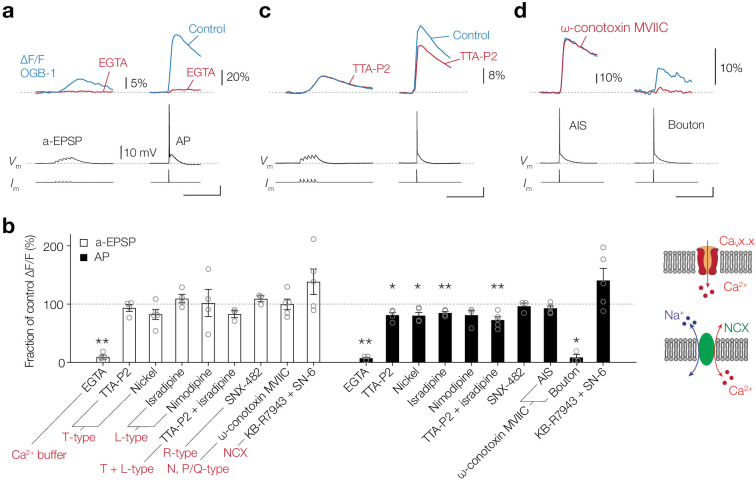
CaV channels play a partial role in activity-dependent Ca2+ entry at the AIS.(a) Top, example traces of ∆F/F (100 μM OGB-1) in the AIS evoked by an a-EPSP (left) and AP (right), before (blue) and after (red) bath application of EGTA (2.5 mM). Bottom, somatic Vm and current-clamp protocols. Scale bars bottom right, 20 mV, 100 ms. (b) Left, population data for the effect of an extracellular Ca2+ buffer, CaV channel blockers and NCX on the peak ∆[Ca2+]i signal in the AIS in response to an a-EPSP (open bars) and AP stimulation (closed bars). Data are shown as ratio to the pre-drug peak Ca2+ responses measured in the same neuron. One-tailed ratio paired t-tests, *p<0.05 and **p<0.01. Open circles represent individual cells and the bars show the mean ± s.e.m. Right, schematics of Ca2+ entry in the axoplasm via CaV channels (top) or NCX (bottom). (c) Top, example traces of ∆F/F in the AIS evoked by an a-EPSP (left) and AP (right), before (blue) and after (red) bath application of TTA-P2 (1 µM). Bottom, somatic Vm and current-clamp protocols. Scale bar, 20 mV, 100 ms. (d) Top, example traces of ∆F/F evoked by an AP in the AIS (left) and presynaptic bouton of the same neuron (right), before (blue) and after (red) puff application of ω-conotoxin MVIIC (2 µM). Bottom, somatic Vm and current-clamp protocols. Scale bar, 20 mV, 100 ms. Data available in Figure 3—source data 1.